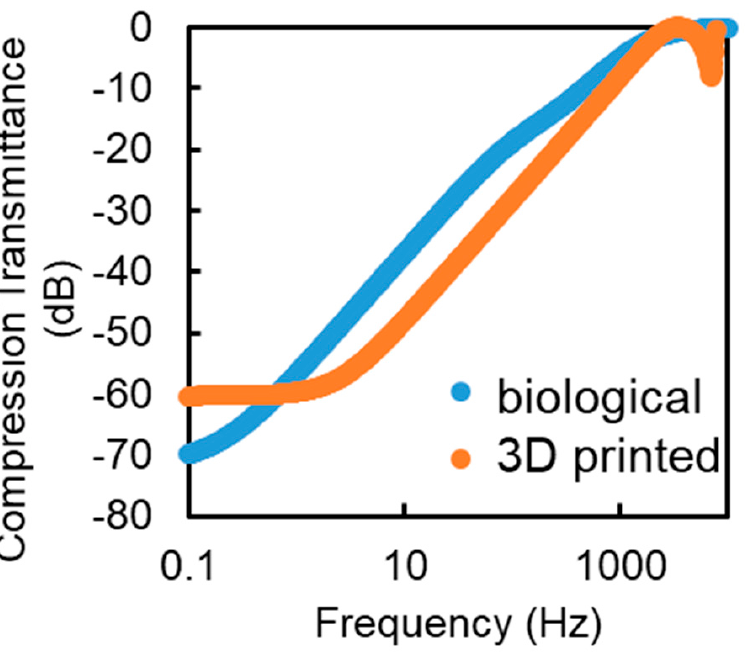
Figure 4. Simulation results for compression transmittance of a typical PC (blue) compared with a 5 layer 3D printable PC